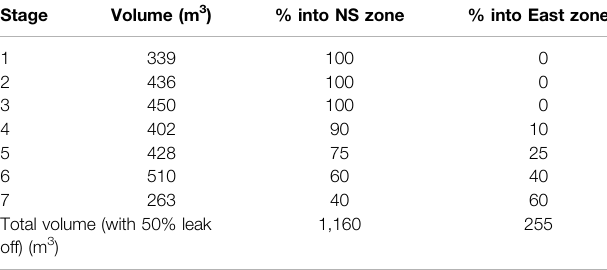
TABLE 2 | Injection volumes for each stage, and our apportionment of their volumes into the NS and Eastern hydraulic fracturing